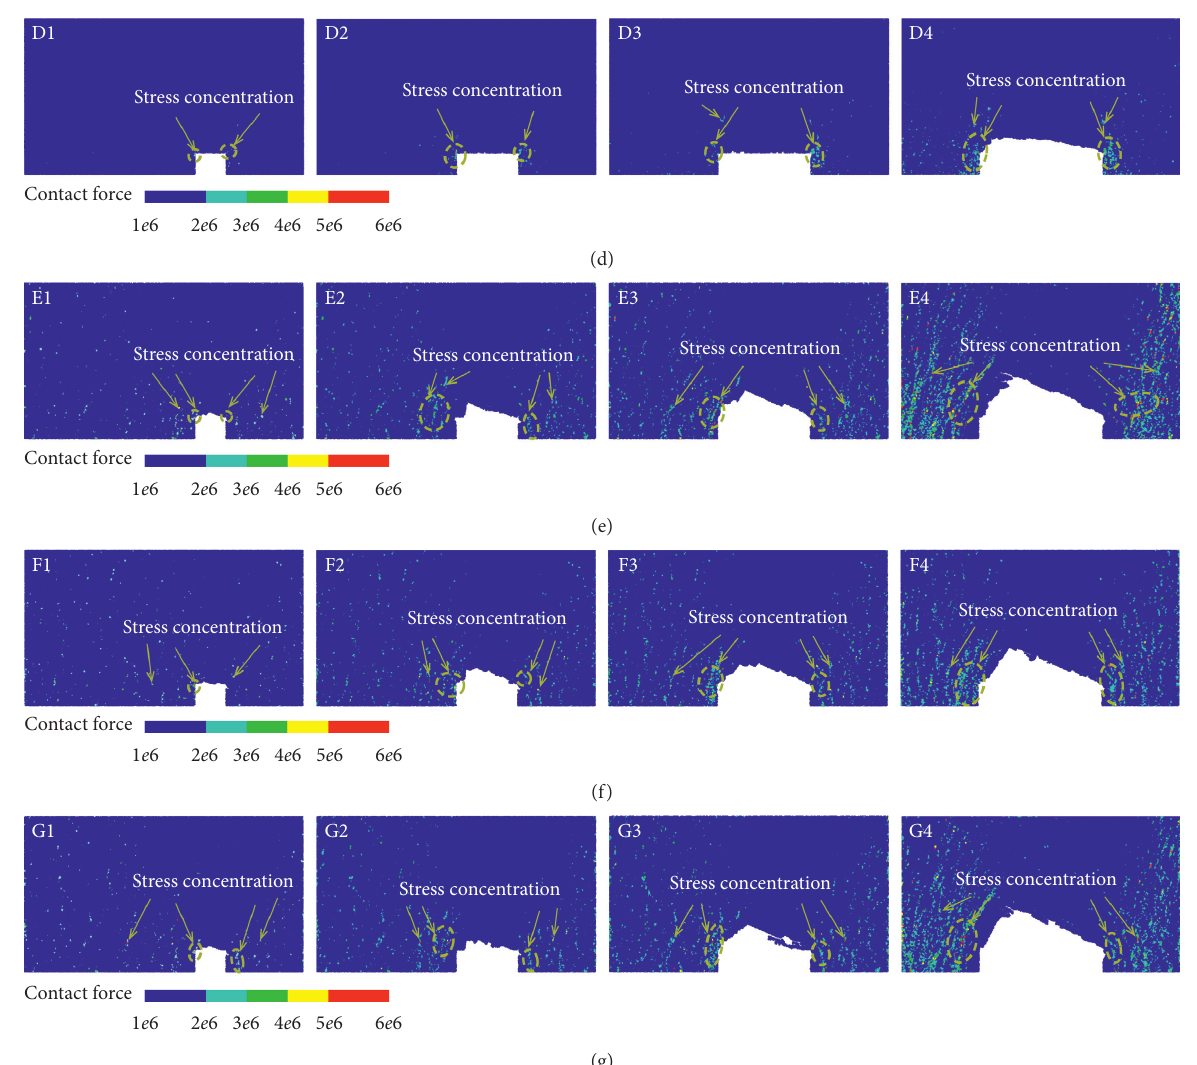
Figure 7: Stress distribution of the seven models. (a) No joints. (b) 24 ° joint set. (c) 124 ° joint set. (d) 98 ° joint set. (e) Joint system 1. (f) Joint system 2. (g) Joint system